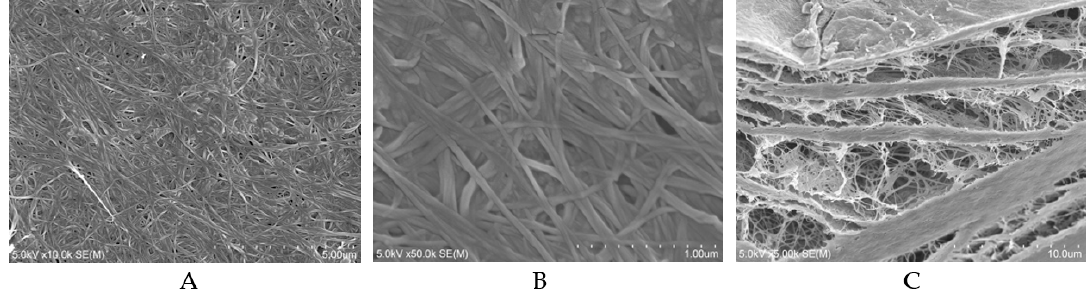
Figure 1. SEM micrographs of surface and cross-section of BC. ( A ) The surface of BC observed under 10.0 kx magnification. ( B ) The surface of BC observed under 50.0 kx magnification. ( C ) The cross-section of BC observed under 5000× magnification.